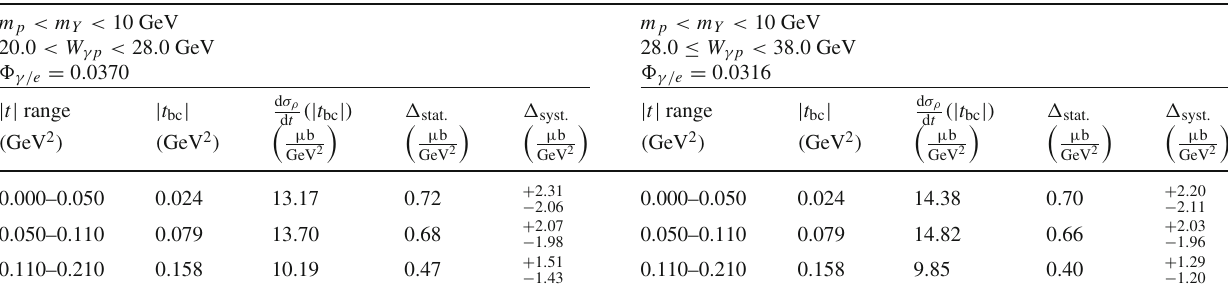
Table 13 Proton-dissociative ( m p < m Y < 10 GeV) differential ρ 0 meson photoproduction cross section d σ(γ p → ρ 0 Y )/ d t in bins of W γ p and t . The cross section is obtained by analysing the π + π − pho- toproduction cross section given in Table 23 with the fit model defined in Eq. (18). The effective photon flux factors (cid:14) γ/ e for each W γ p bin